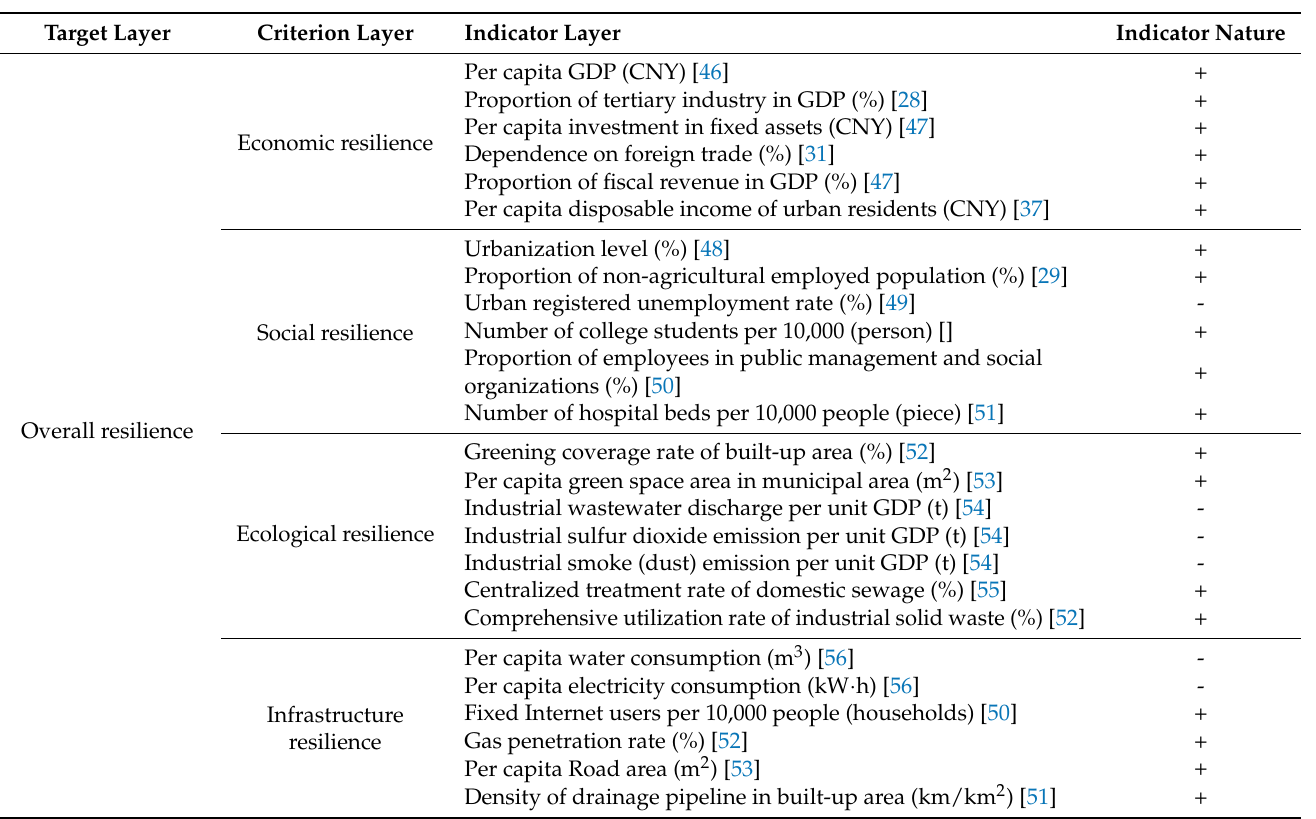
Table 1. Evaluation Index